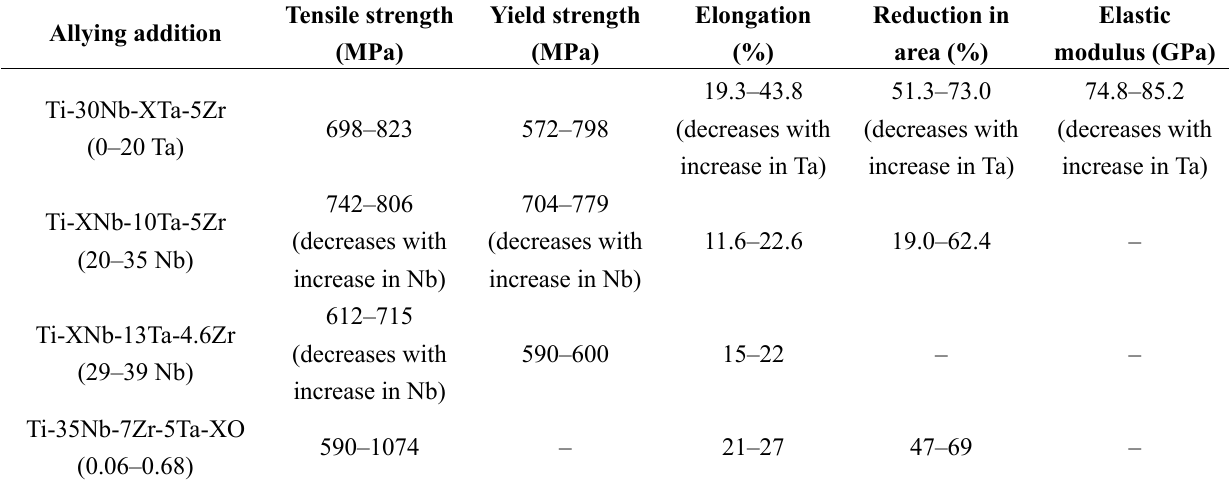
Table 10. Effect of alloying addition on the mechanical properties of β -type Ti-Nb-Ta-Zr alloys [61]. Reprinted with permission from [61]. Copyright 2009